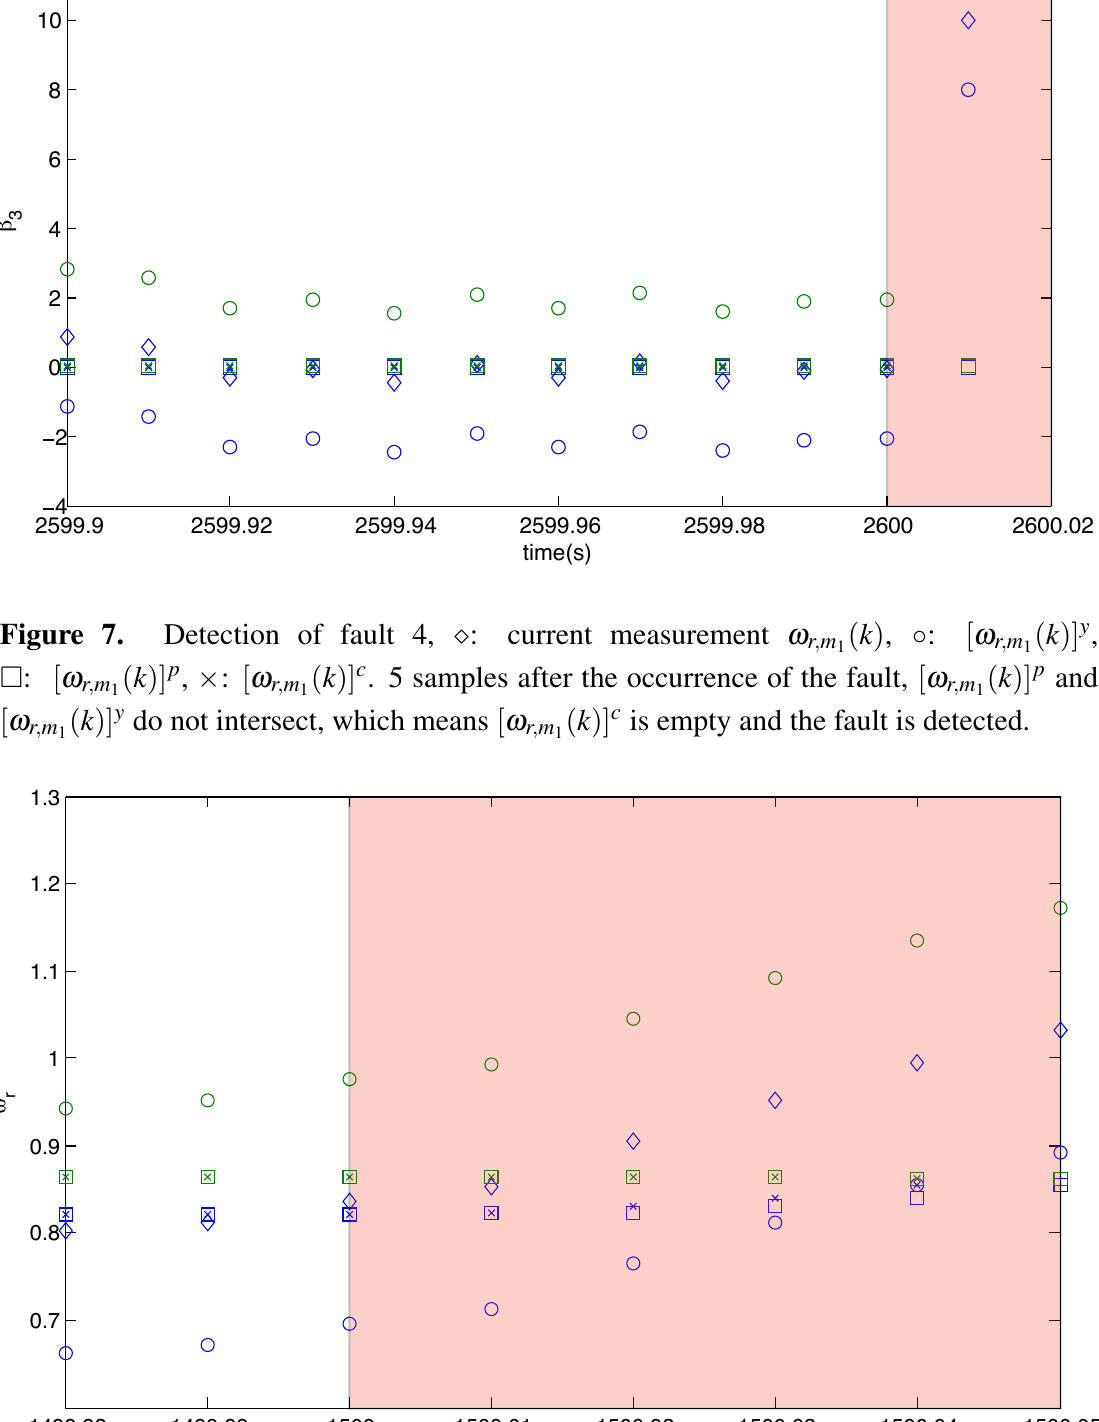
( k )] c is empty and the fault is detected. 3